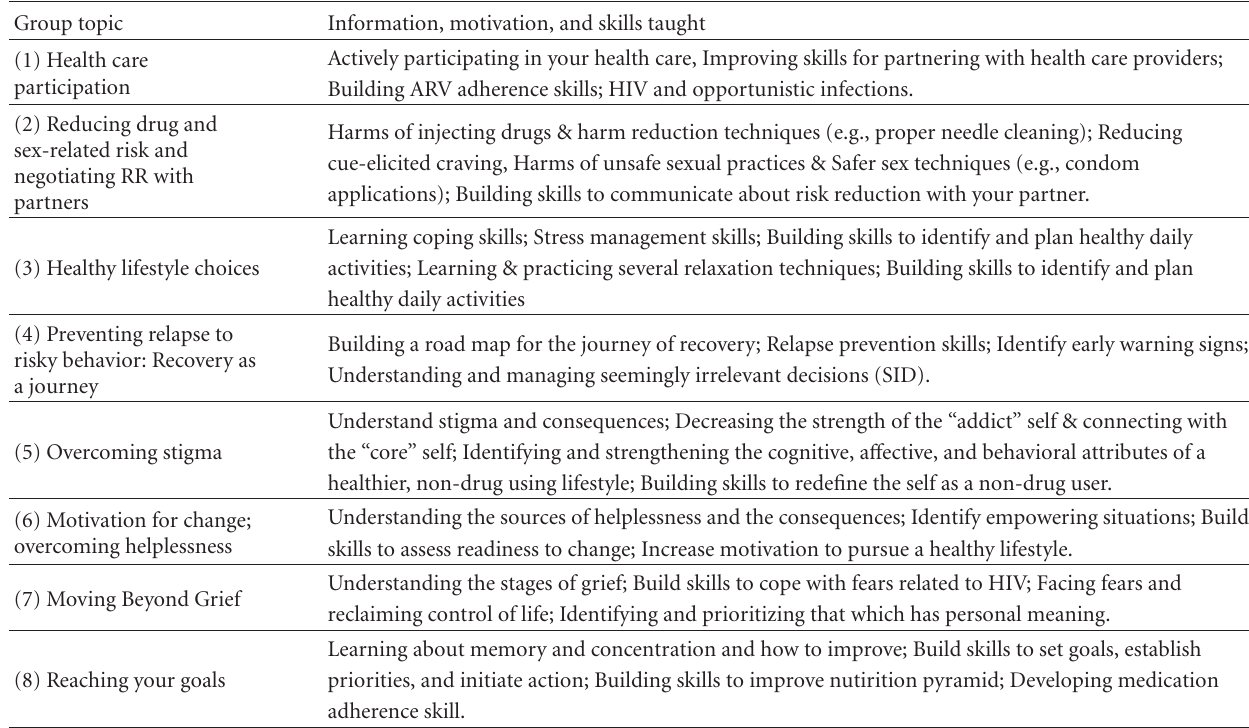
Table 4: Outline of adapted intervention